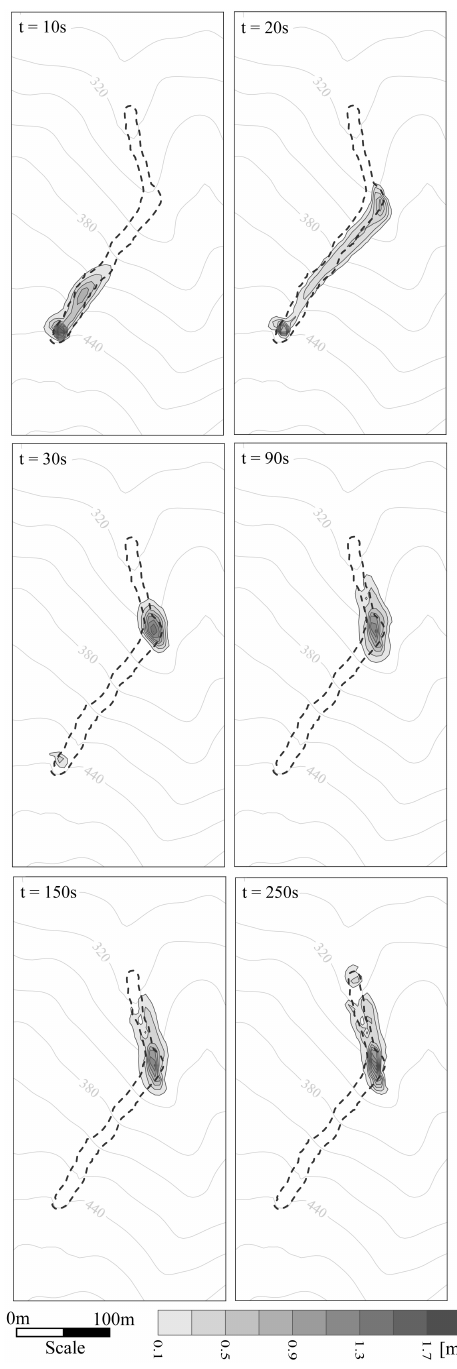
Fig. 4. The August 2005 debris flow – dilled depth contours of sliding debris (Frictional rheology). The dotted line indicates the extent of the real event